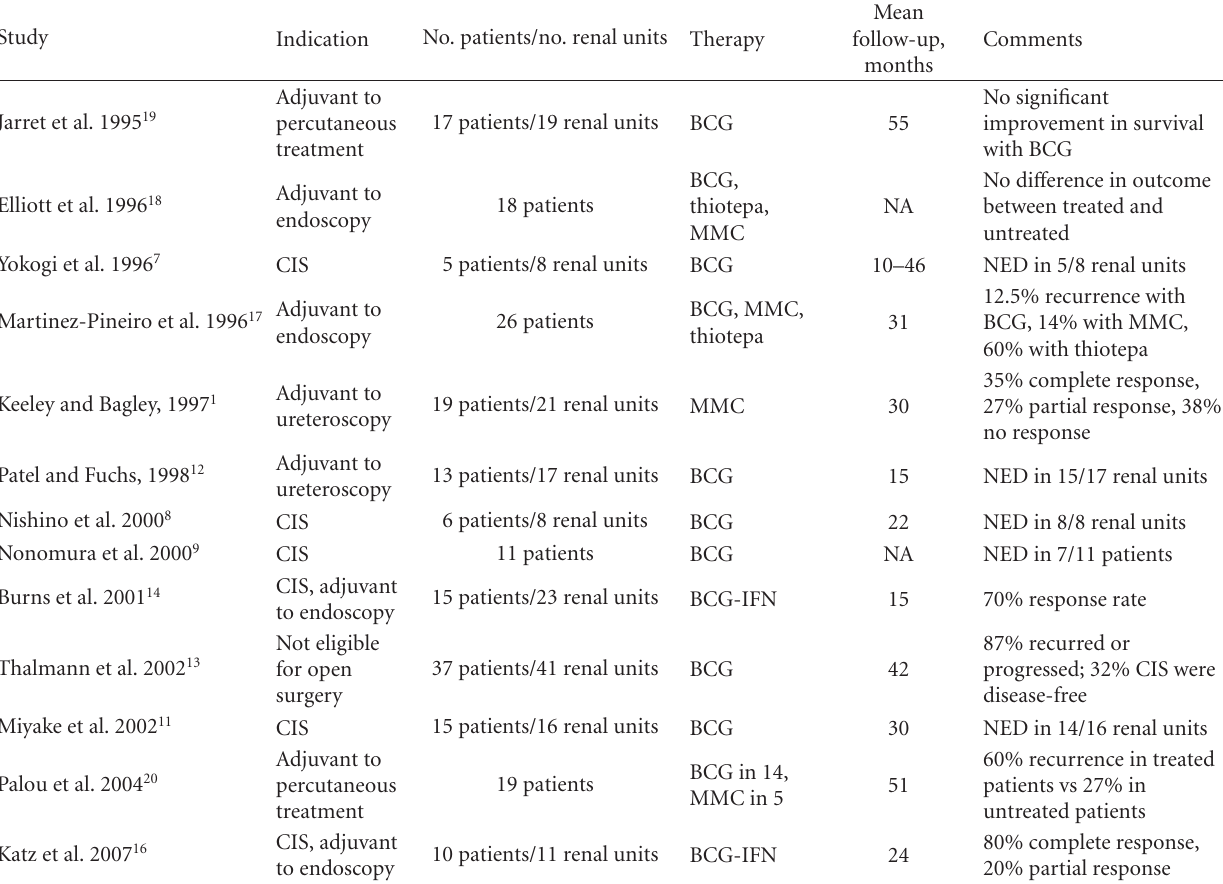
Table 2: Topical therapy of upper tract urothelial